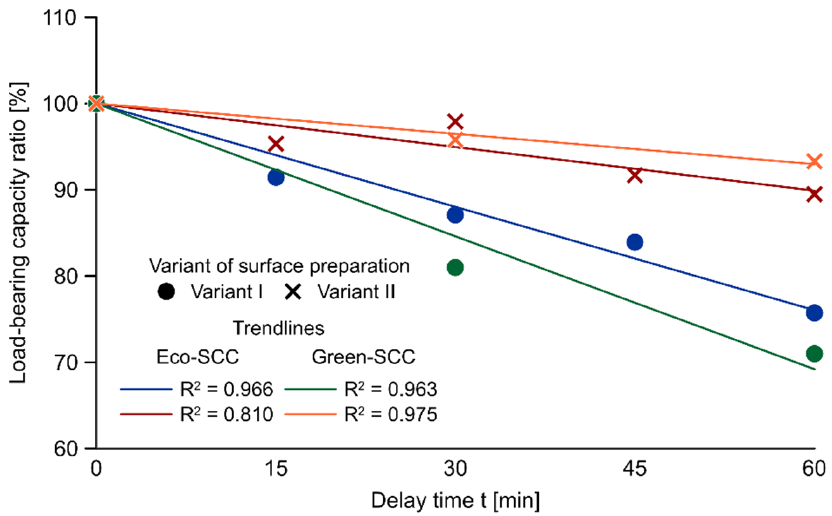
Figure 5. The relation between the load-bearing capacity ratio and delay time of subsequent layers.